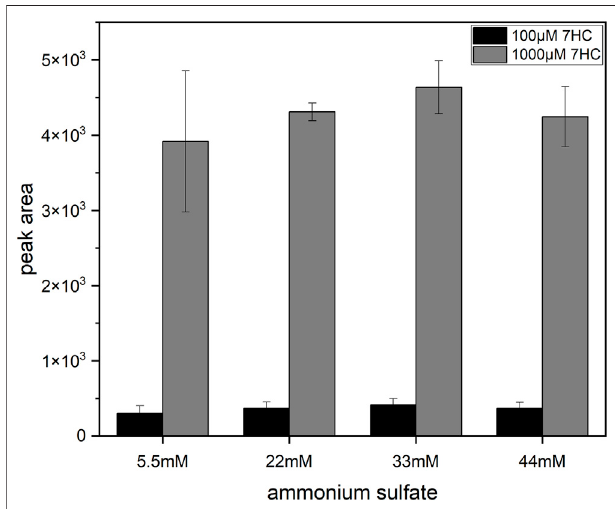
FIGURE 6 | In fl uence of (NH 4 ) 2 SO 4 and substrate concentrations on 7HCSU formation from 7HC by SULT2A1. Each experiment was done in triplicates. Error bars show the standard deviations.